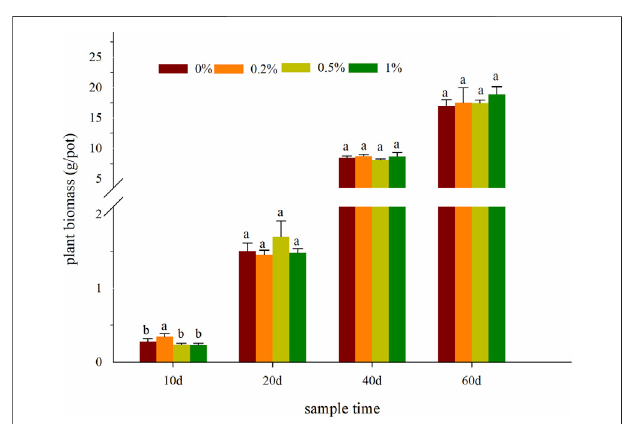
FIGURE 3 | Effects of NMMT application on the dry weight. The letters indicate signi fi cant differences between members of the same set ( p < 0.05).